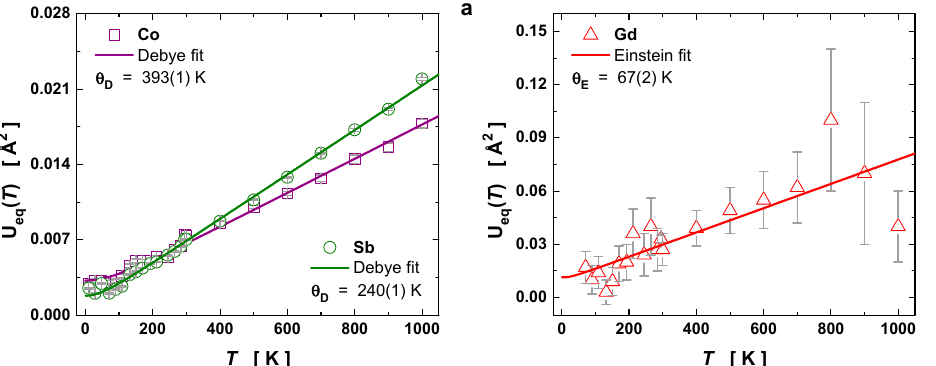
Figure 3. Temperature dependence of the mean-square displacements U eq ( T ) (or MSDs in units of Å 2 ) for the atoms ( a ) Co, Sb and ( b ) Gd. The Co–Sb framework was evaluated using the Debye approximation, while the dynamic behavior of the filler Gd was fitted to the Einstein model.